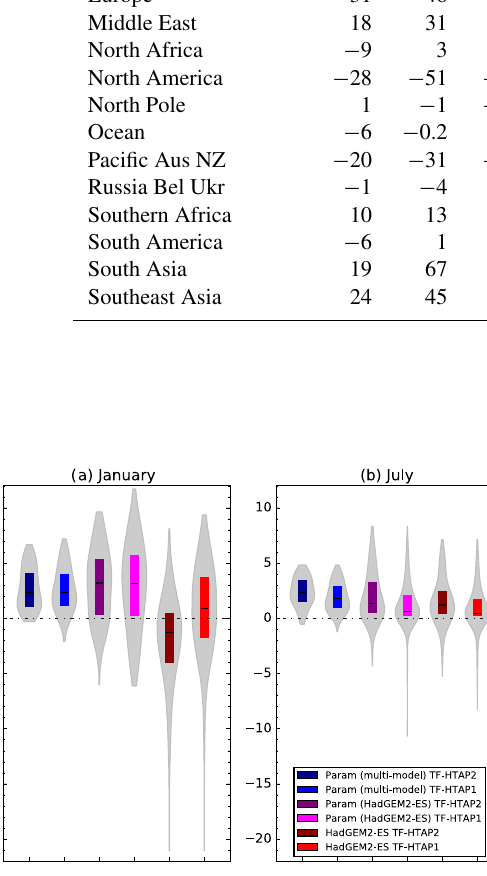
Figure 4. January (a) and July (b) monthly mean surface O 3 changes over south Asia between 2010 and the ECLIPSE V5a CLE emission scenario in 2030 for HadGEM2-ES and the parameterised response based only on HadGEM2-ES and on multiple models. O 3 responses are calculated over the south Asia region as defined in both TF-HTAP1 and TF-HTAP2 (Fig. 1). Grey shading represents the spatial distribution of O 3 changes across all grid boxes, coloured boxes show the range of the 25th to 75th percentile values, and the solid line shows the median value over the south Asia